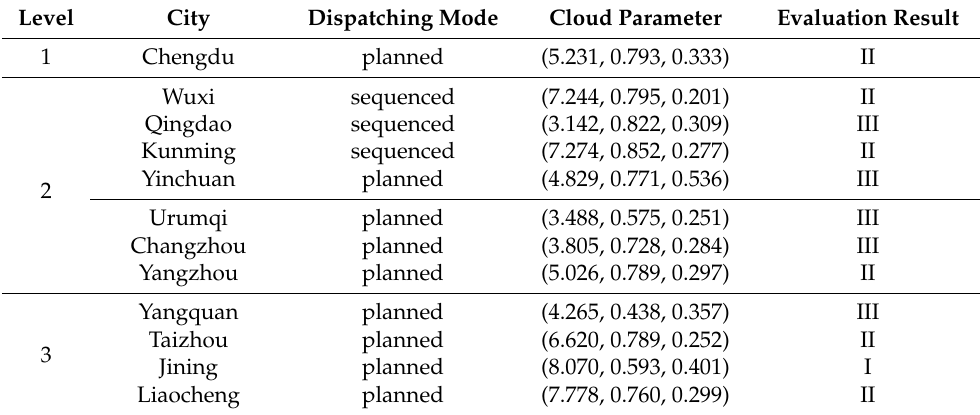
Table 11. Evaluation results of APTS dispatchers’ scheduling level.